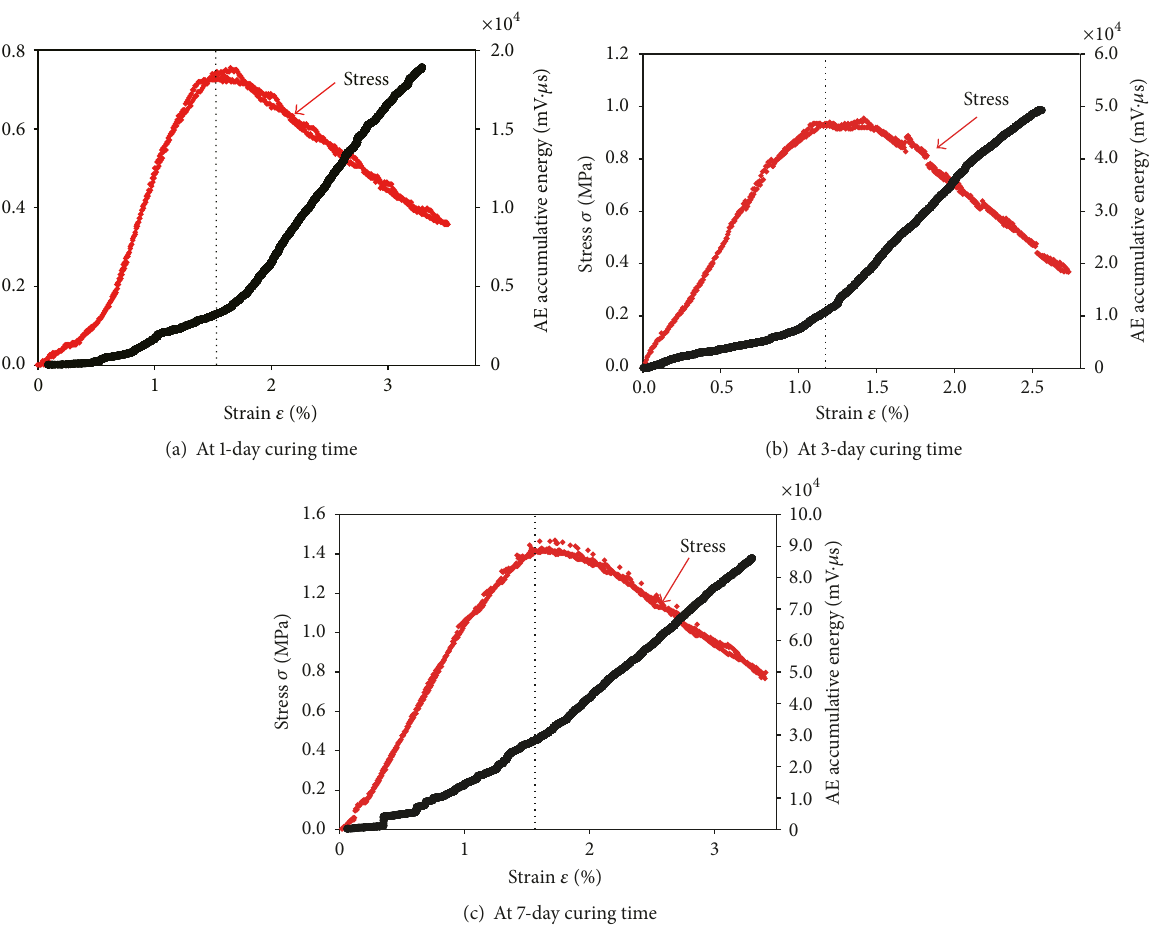
Figure 11: Relational graph of CGB stress and AE cumulative